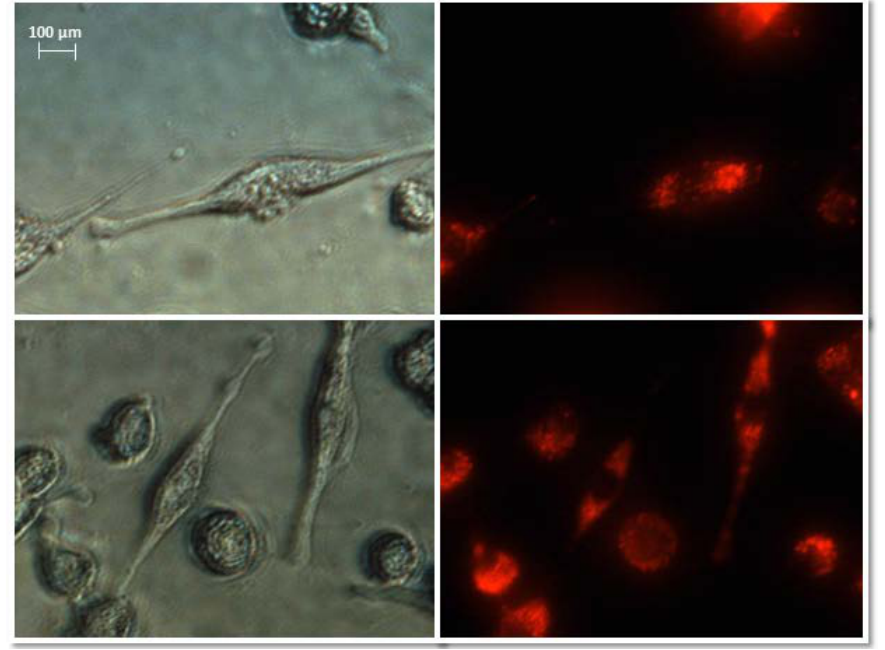
Figure 6. Representative images of NHDF cells ( left , visible light) after treatment with exosomes ( right , Vybrant ™ CM-Dil stained—red). Nikon Eclipse Ti, magnification